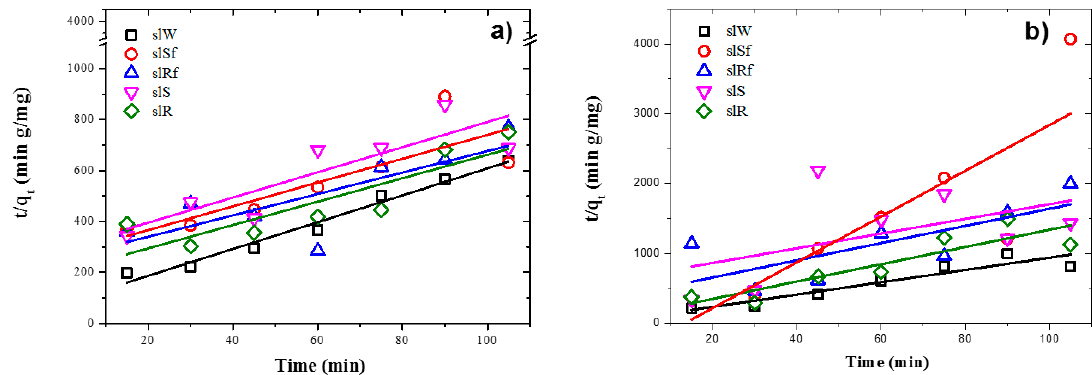
Figure 9. Plots of the pseudo-second order kinetics of MB adsorption on metallurgical slag-based alkaline cements with addition of ZnO nanoparticles in; ( a ) under UV irradiation and ( b ) dark Table 5. XRF analysis (wt.%) of Tizayuca kaolin and metallurgical